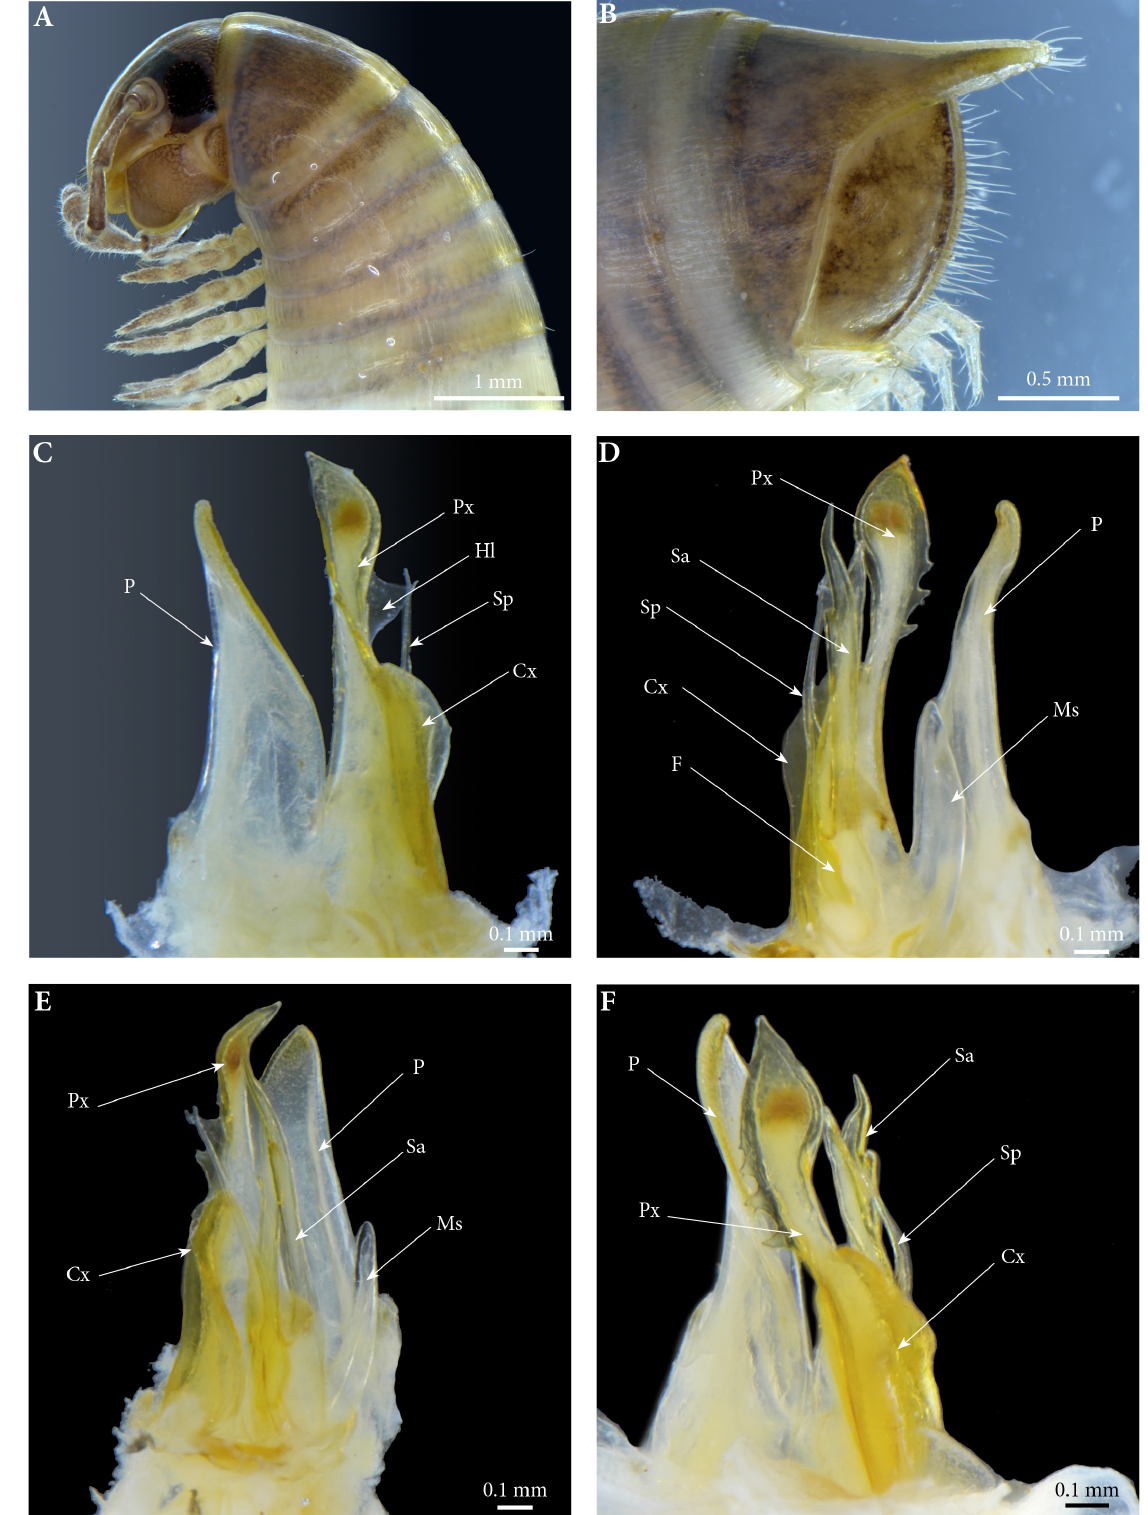
Fig. 9. Ommatoiulus denticulatus sp. nov. Holotype ♂. A . Head and anteriormost body-rings, lateral view. B . Telson, lateral view. C . Right gonopod, lateral view. D . Right gonopod, mesal view. E . Right gonopod, posterior view. F . Right gonopod, postero-lateral